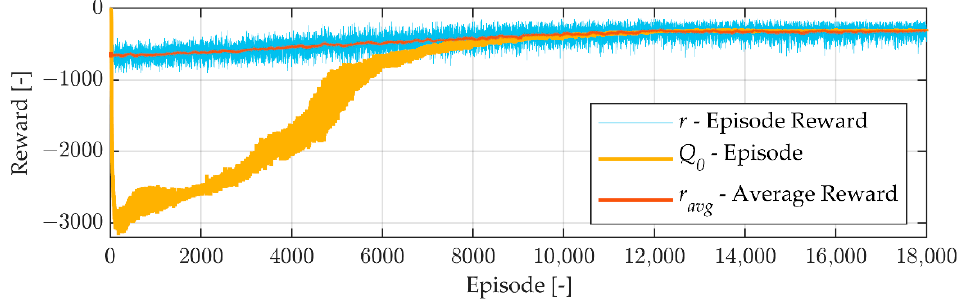
Figure 5. Agent’s training progress.